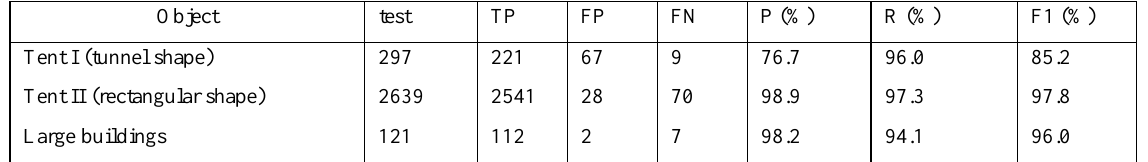
Table 2. Accuracy results of object-based